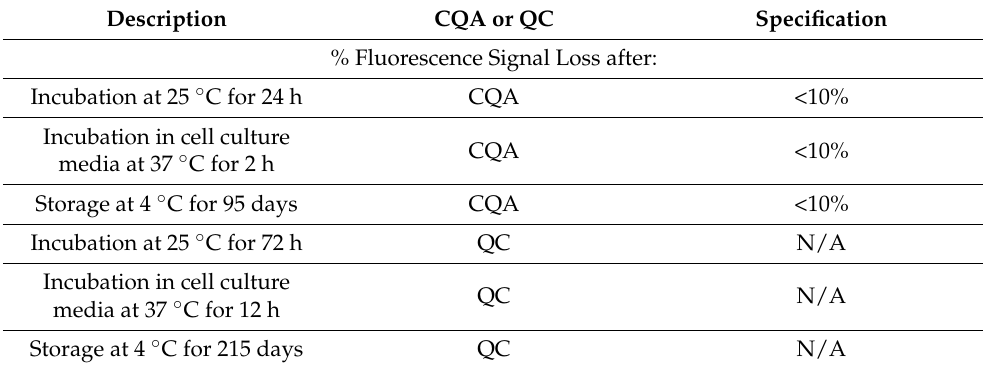
Table 3. Summary of fluorescence critical quality attribute (CQA) and quality control (QC) testing performed on perfluorocarbon nanoemulsions. Description CQA or QC